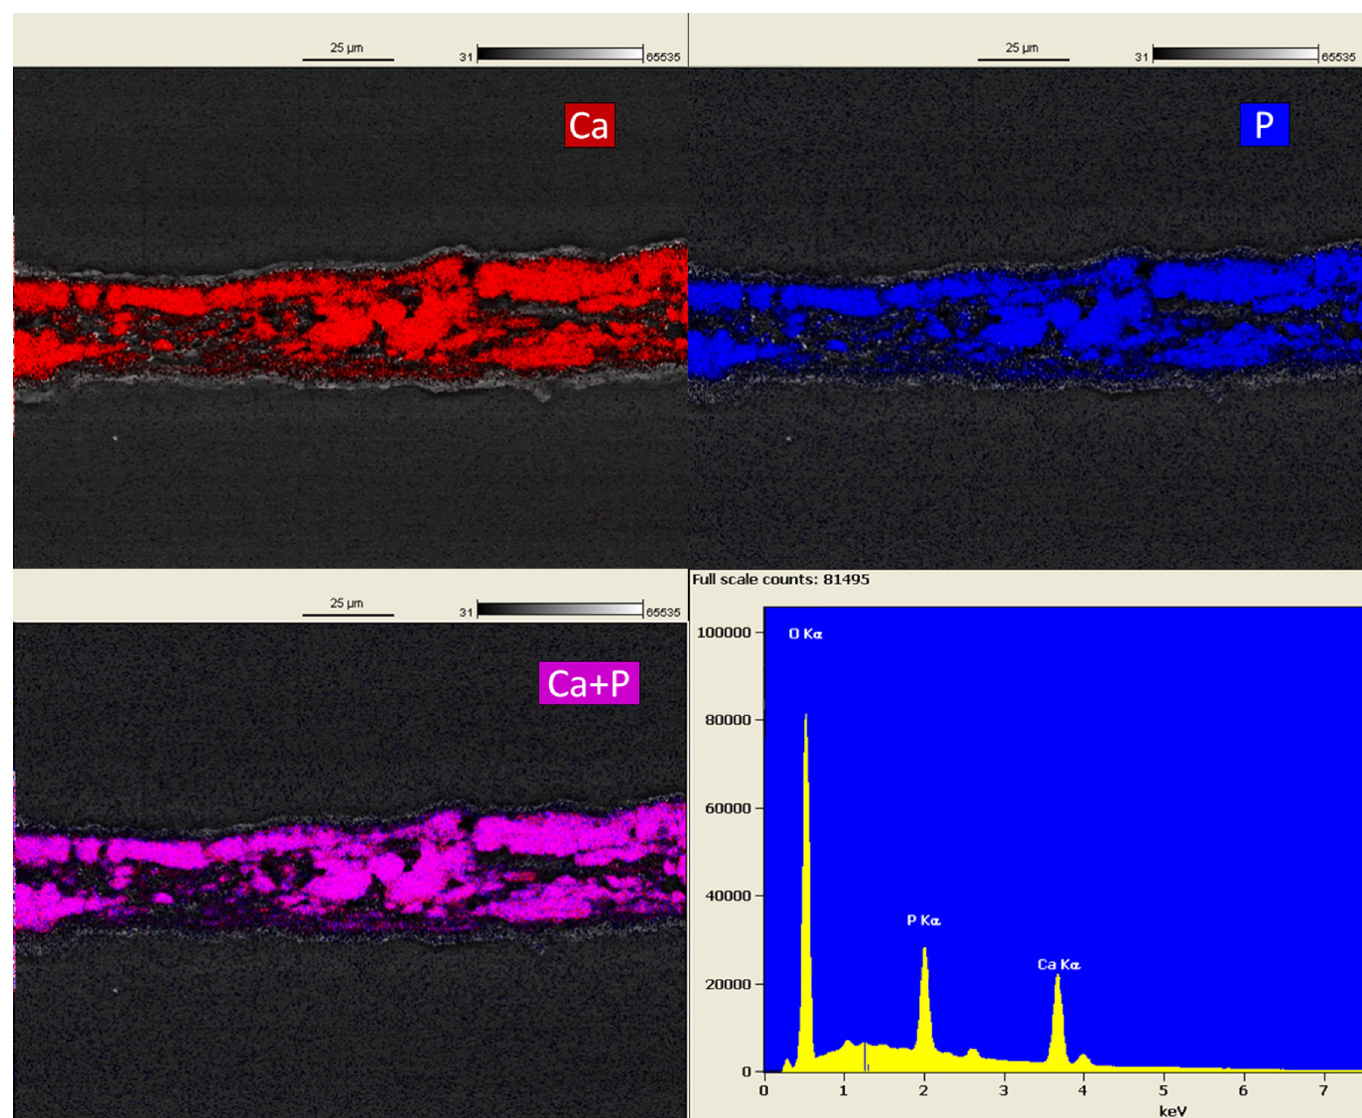
Fig 14. SEM-EDS maps and spectrum from the same section of a no-PEMF control ring construct in Fig 12 with emphasis on Ca, P localization, and their overlay. Ca/P ratio = 1.29. SEM settings: SEM settings: EHT = 15KeV, WD = 11.0 mm, H = 128.3 μ m, W = 171.0 μ m.